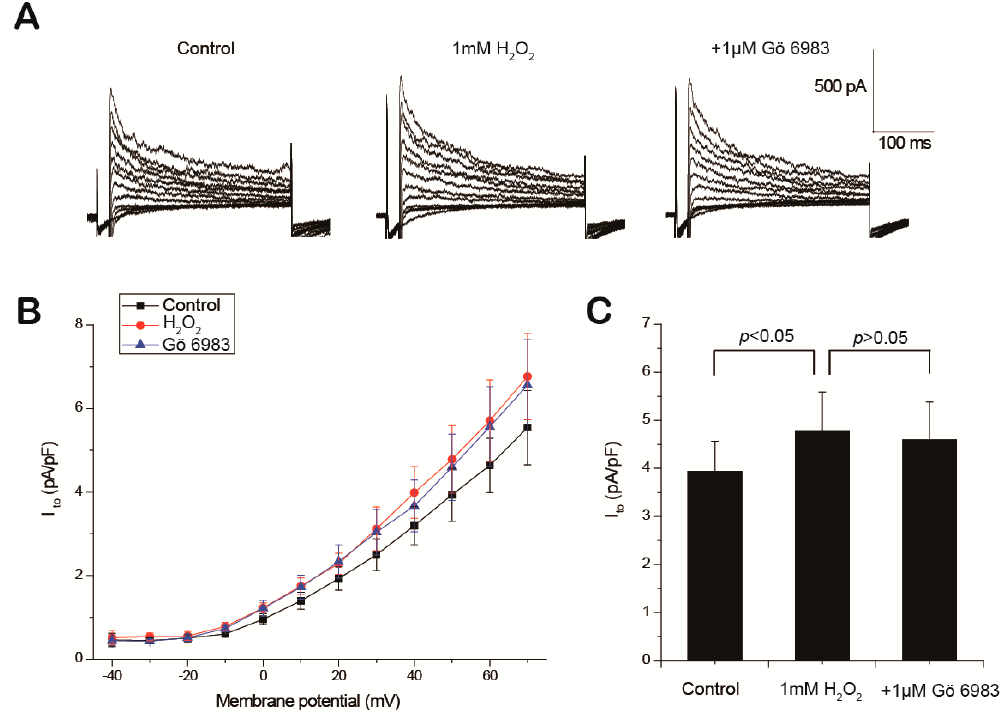
Figure 6. Effects of Gö 6983 on H 2 O 2 -induced transient outward potassium current (I to ) elevation. Representative current–voltage traces ( A ), the averaged current-voltage curves of I to ( B ) and summary histogram of I to at +50 mV ( C ) under control condition, in the presence of 1 mM H 2 O 2 alone or plus 1 μ M Gö 6983 are shown.